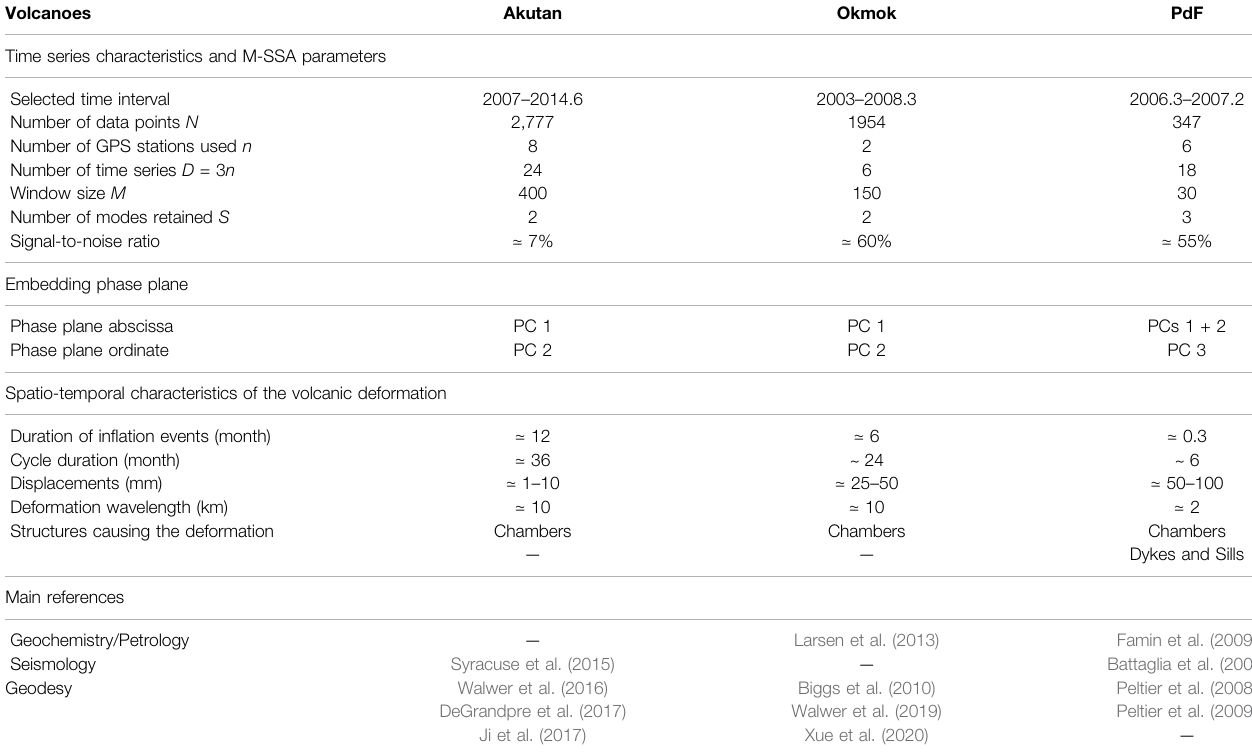
TABLE 1 | Summary of the M-SSA parameters and of the results of the analysis, along with the characteristics of the deformation observed at the volcanoes investigated.